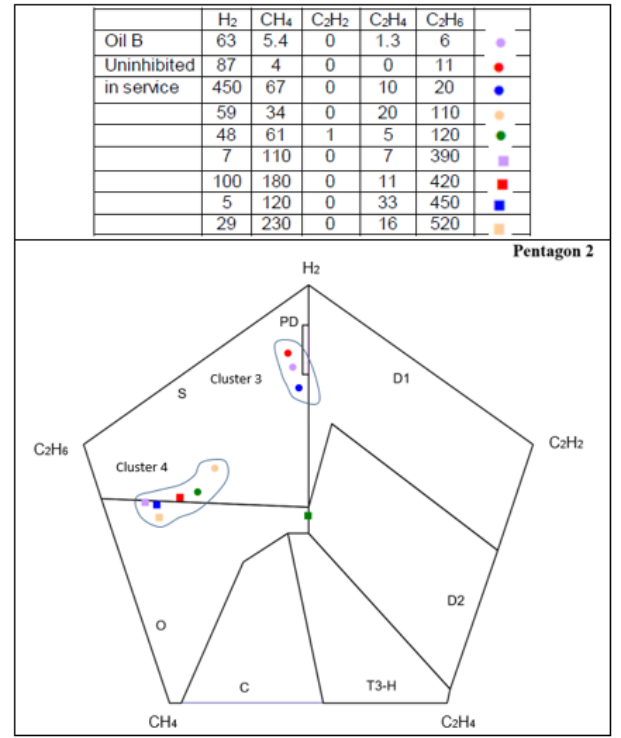
Figure 6. SG of uninhibited mineral oil B in transformers of the FKH, in Clusters 3 and 4.